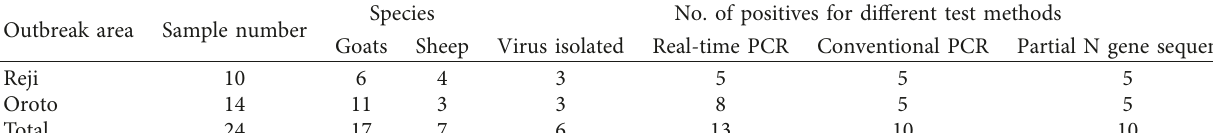
Figure 1: Map of Arero district showing the location of outbreaks of the study areas. Table 1: Description of sample used and test results by different test methods in this study.